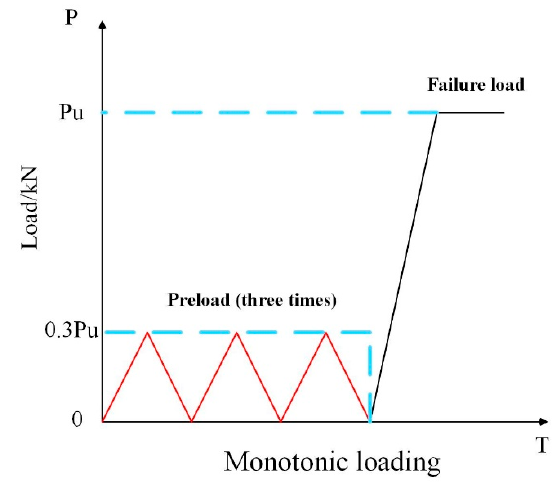
Figure 8. Loading procedure for push-out tests.